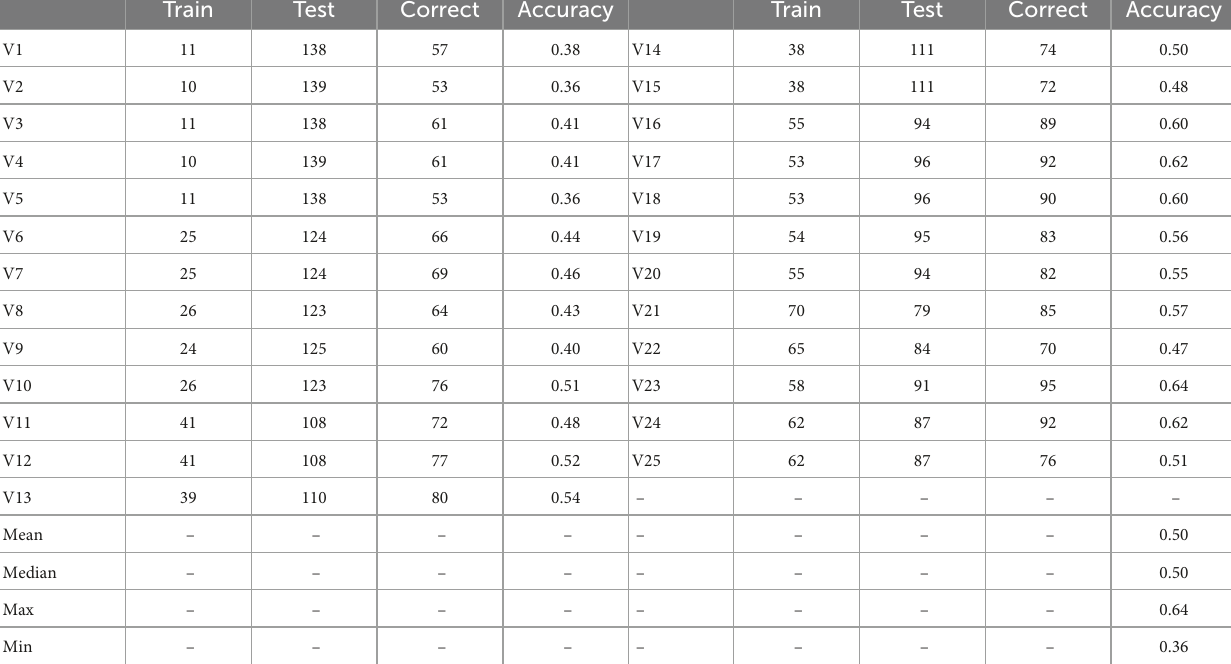
TABLE 1 Training prediction accuracy when Voronoi polygons are the units.